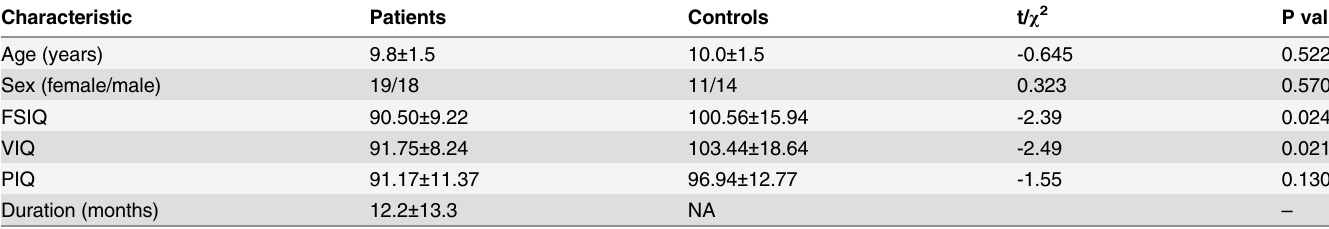
Table 1. Demographic, clinical, and neuropsychological characteristics of BECTS patients and healthy controls.